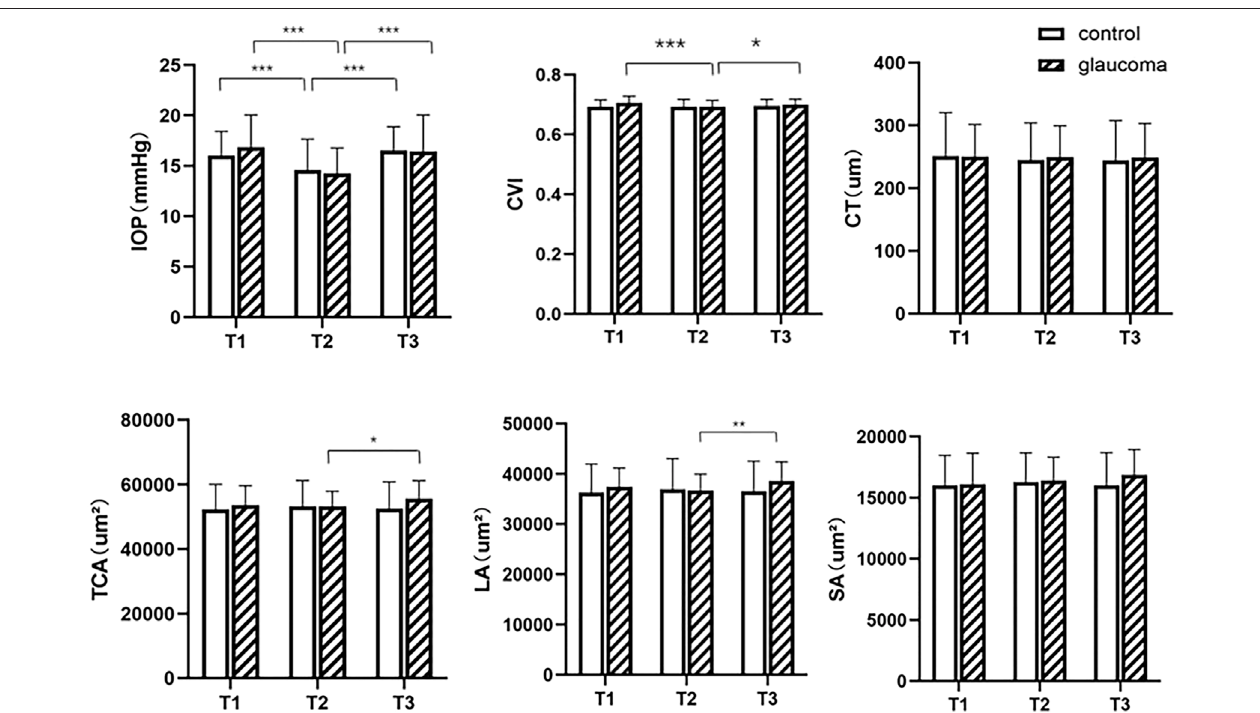
FIGURE2| Intraocularpressure(IOP)andchoroidalparametersbeforeandafterexerciseintheglaucomaandcontrolgroups.T1,beforeexercise;T2,immediately after exercise; T3, 30 min after exercise. CVI = choroidal vascularity index, CT = choroidal thickness, TCA = total choroidal area, LA = luminal area, SA = stromal area.